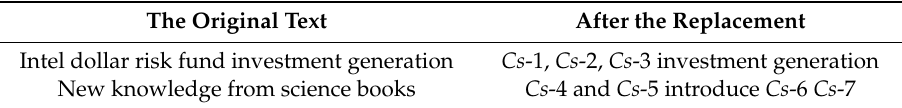
Table 2. Example of feature